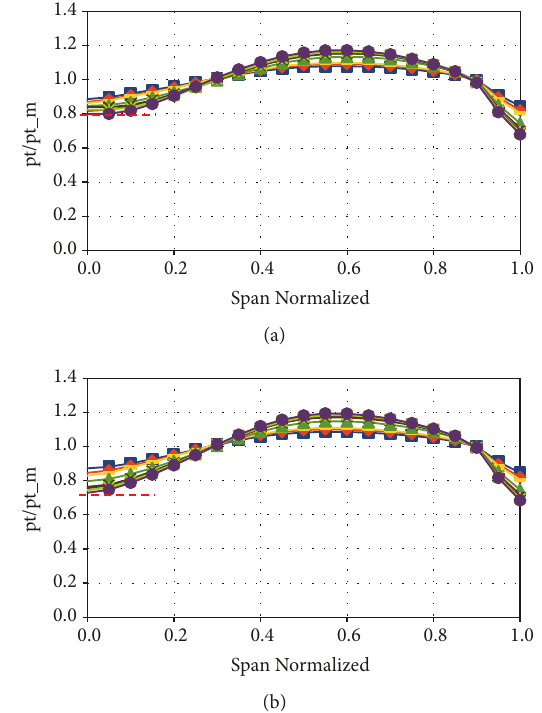
Figure 19: Total pressureratiovs span, partial shroud admission, (a) with cavity and (b) without